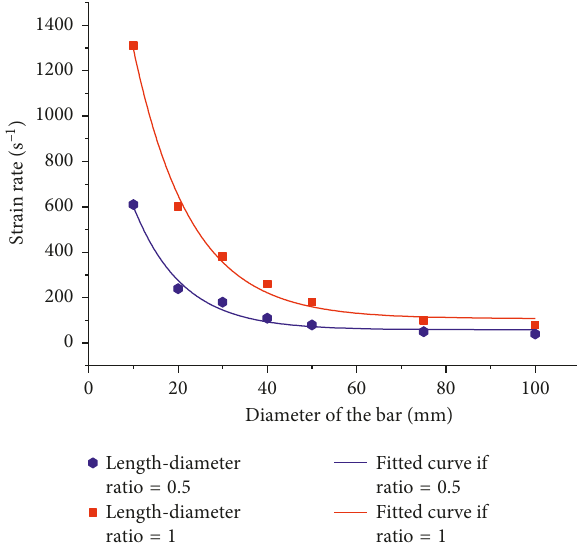
Figure 6: Fitted curves representing the relationship between the minimum strain rate and bar